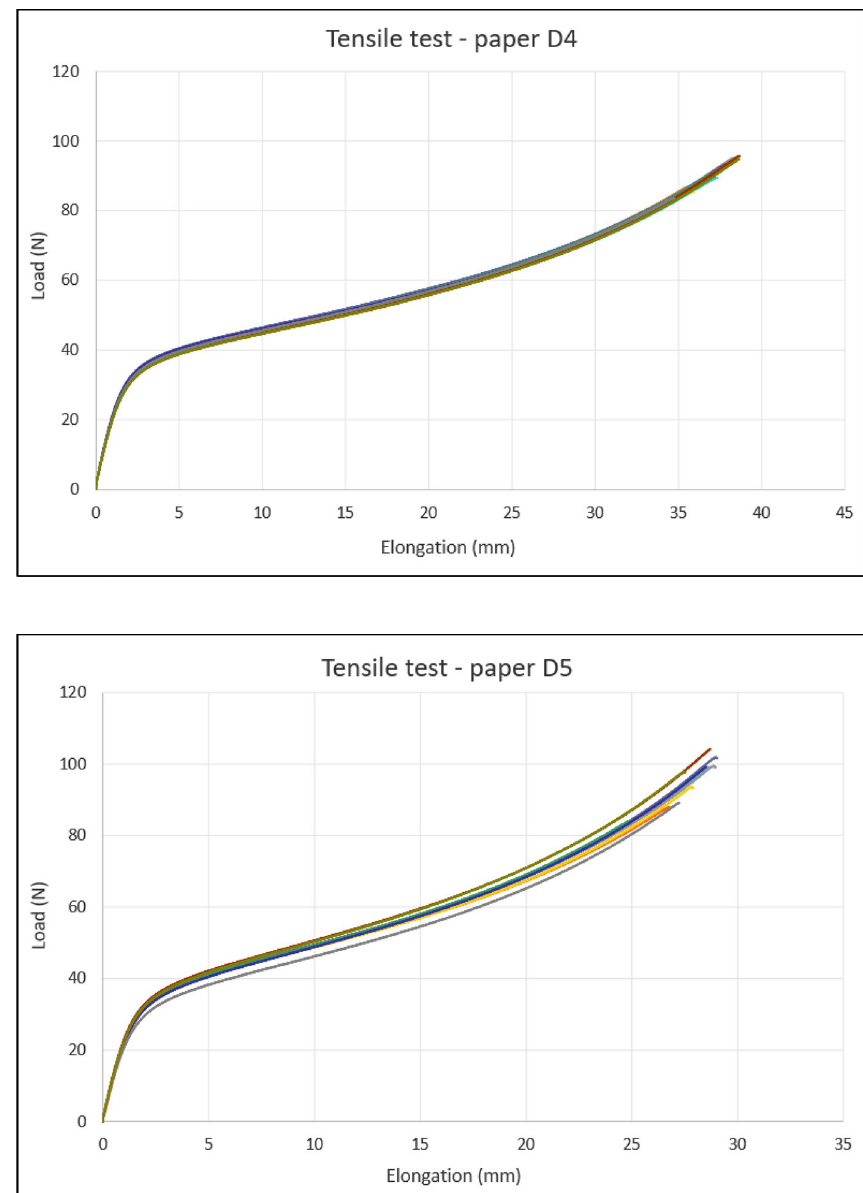
Fig. 34 Force elongation curves of individual specimen of paper D4